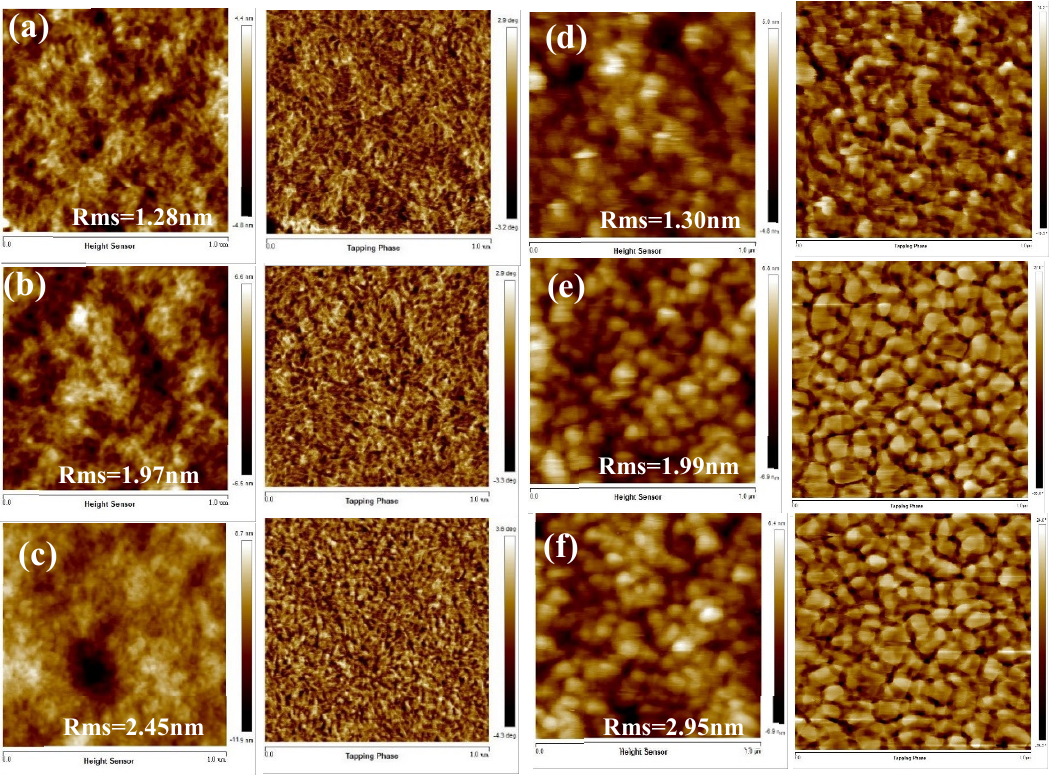
Figure 4. Tapping-mode AFM (1 × 1 μm) images (left: topographic images, right: phase images) of blend films deposited with various TiO 2 -SiO 2 ratios and addition of Jeffamine D2000 or polyurethane;